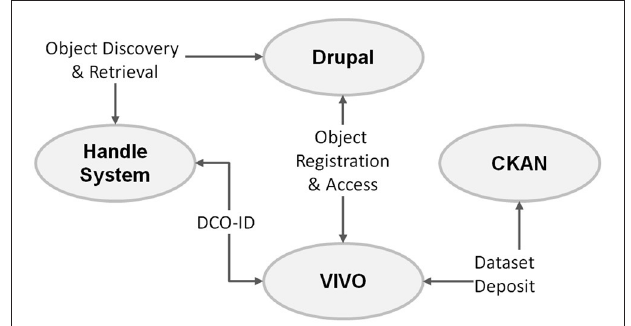
FIGURE 2 | A schematic view of the DCvO technological